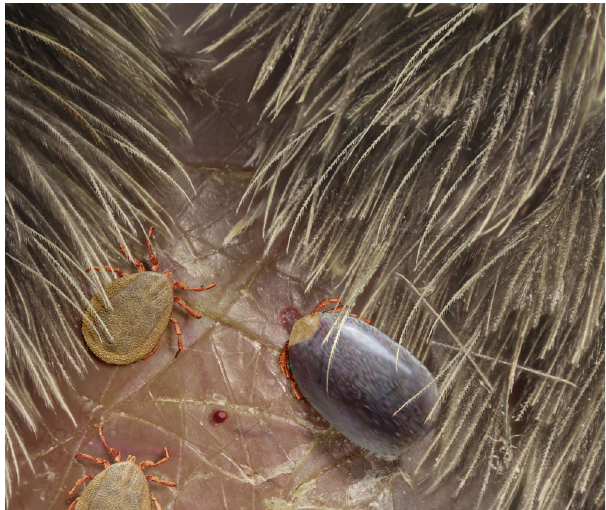
Fig. 9 Reconstruction of the habitus of Deinocroton draculi on an immature feathered dinosaur. The reconstruction shows two unengorged males (left) and a female feeding to engorgement (right). Male body length ca. 3.9 mm. Colours of the ticks are conjectural but based on the colouration seen in the related nuttalliellid ticks. Performed by the authors using models of the males created by the artist Oscar